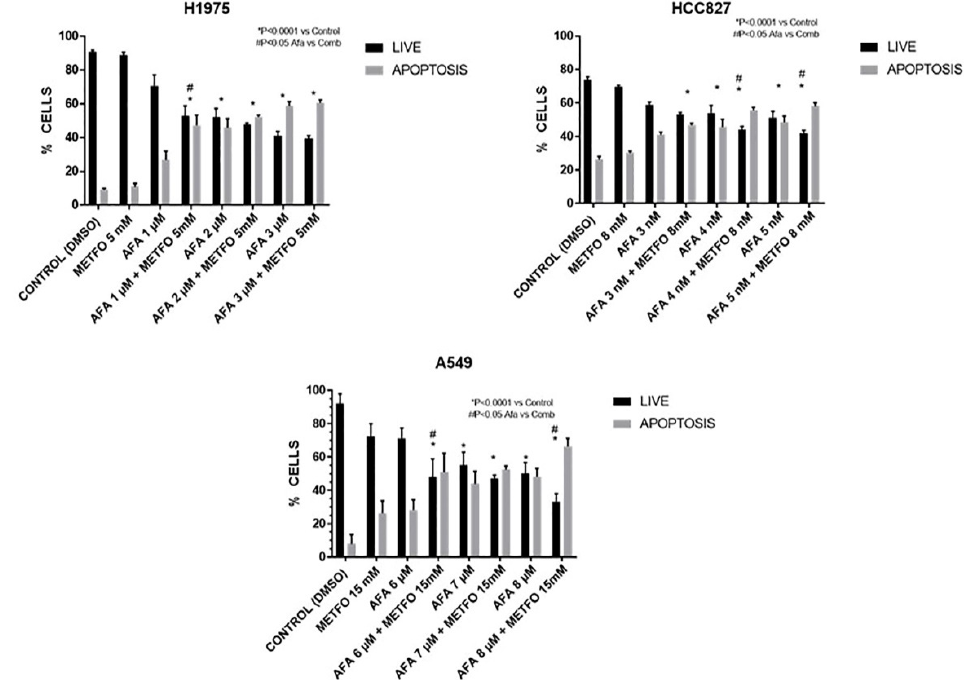
Figure 2. Apoptosis induction of afatinib plus metformin treatment in H1975, HCC827, and A549 cell lines. We observed similarities between the apoptosis test and cytotoxicity induction results. In total, 5000 events were analyzed in each assay. Cells were seeded and treated with the previously described scheme for 72 h and then analyzed with the apoptosis kit and flow cytometry. Bars represent the means of 3 independent experiments by triplicate. Statistical references are presented in each graph. * p < 0.0001 vs control, # p < Afa vs.